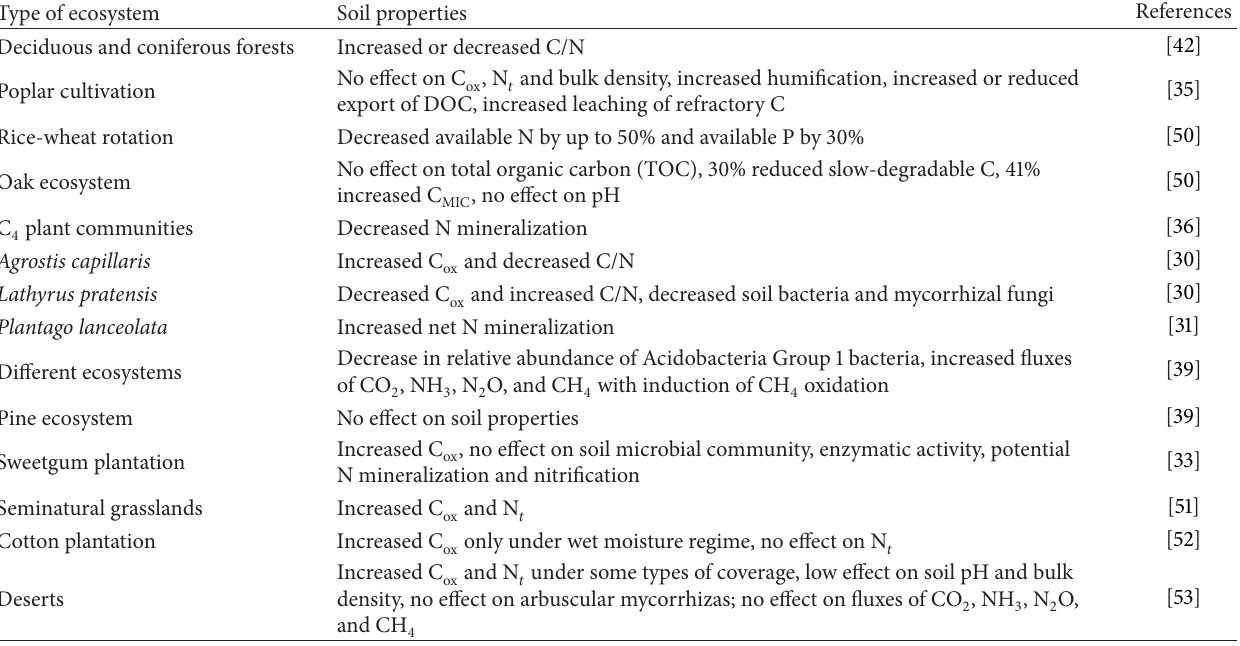
on soils according to type of 2